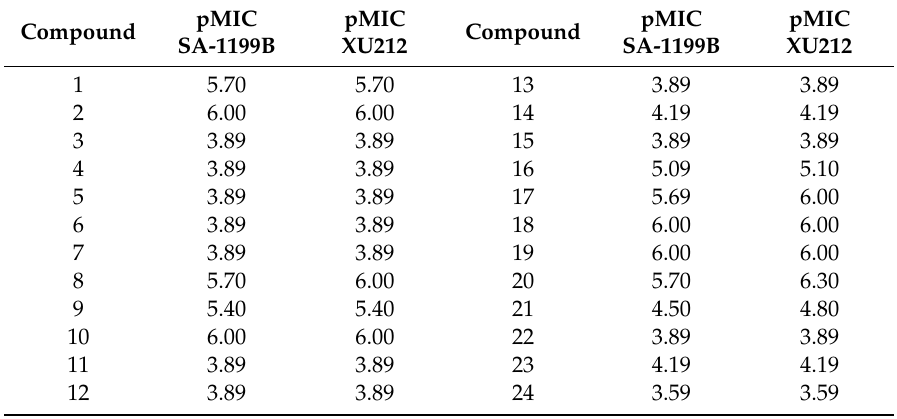
Table 1. MIC, minimum inhibitor concentration, values for the cannabinoids in this study toward drug-resistant SA-1199B and XU212 of Staphylococcus